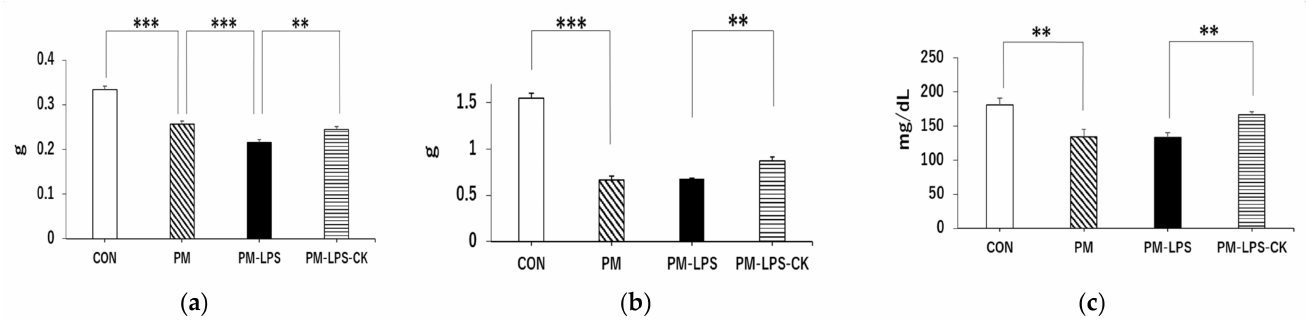
Figure 3. Effects of dried C. kawachiensis peel powder on protein malnutrition or LPS-induced periph- eral dysfunction. Comparison of collected ( a ) gastrocnemius weight, ( b ) liver weight, and ( c ) blood glucose concentration in the 8-day group. Values are means ± SEM. Symbols show significant differences for the following conditions: CON vs. PM (*** p < 0.001, ** p < 0.01), PM vs. PM–LPS (*** p < 0.001), and PM–LPS vs. PM–LPS–CK (** p < 0.01, *** p < 0.001). The number of mice in each group is as follows: CON: n = 8, PM: n = 8, PM–LPS: n = 7, PM–LPS–CK: n = 7.